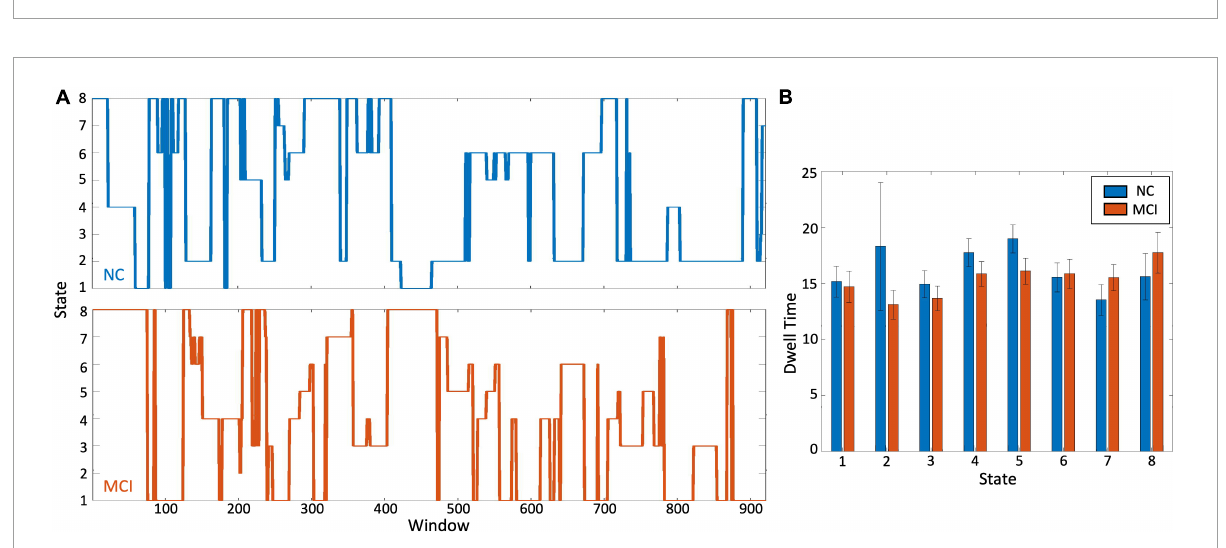
FIGURE3 Differences in brain state dwell time. (A) Representative time course of window transitions over the duration of the scan for a healthy control participant in blue and an MCI participant in orange. There is no one-to-one correspondence between the two time-courses. (B) Comparing the dwell time i.e., time (in terms of number of windows) spent in each state, there was no significant difference between the two groups. Table 2 shows the actual dwell